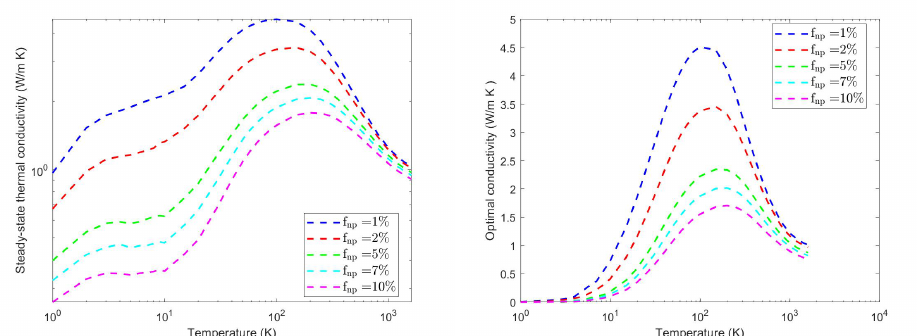
Figure 11. ( Left ): Steady-state thermal conductivity versus T for various values of the fraction of nanoparticles with radius R = 3 nm in Si 0.7 Ge 0.3 . ( Right ): Minimum steady-state thermal conductiv- ity versus T for various volume fractions of